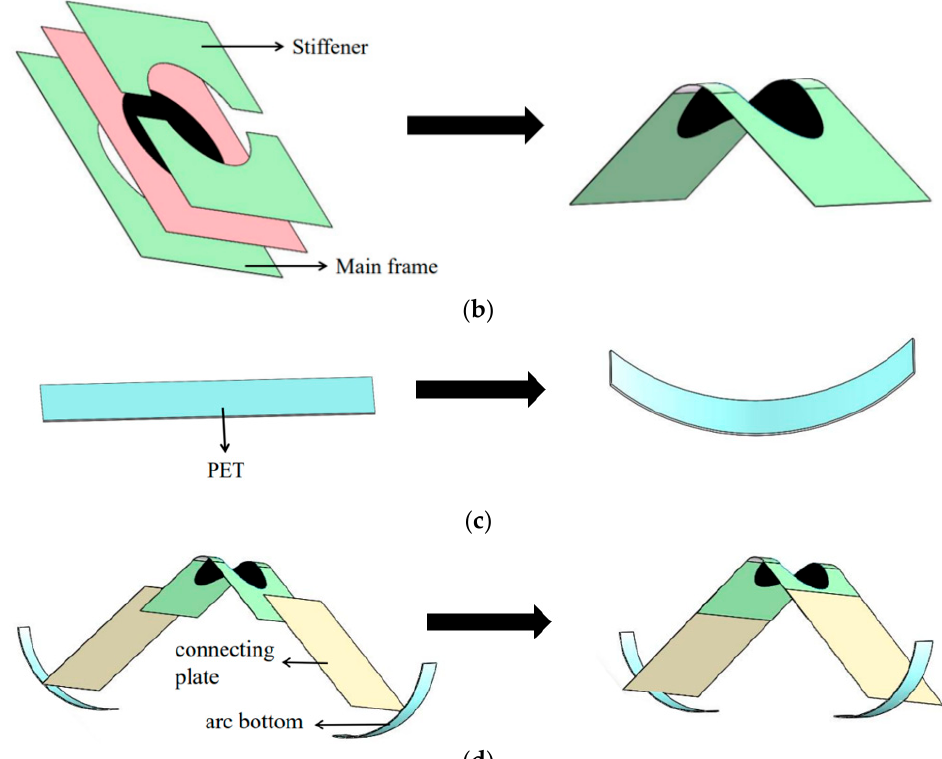
Figure 2. Manufacturing process of the bionic inchworm soft robot. ( a ) Pre-stretching of DE and coating of electrodes. The carbon grease on both sides is connected to the negative electrode (“-”), and the carbon grease in the middle is connected to the positive electrode (“+”); ( b ) Fabrication of actuator; ( c ) Fabrication of arc bottom; ( d ) Assembly of bionic inchworm soft robot.